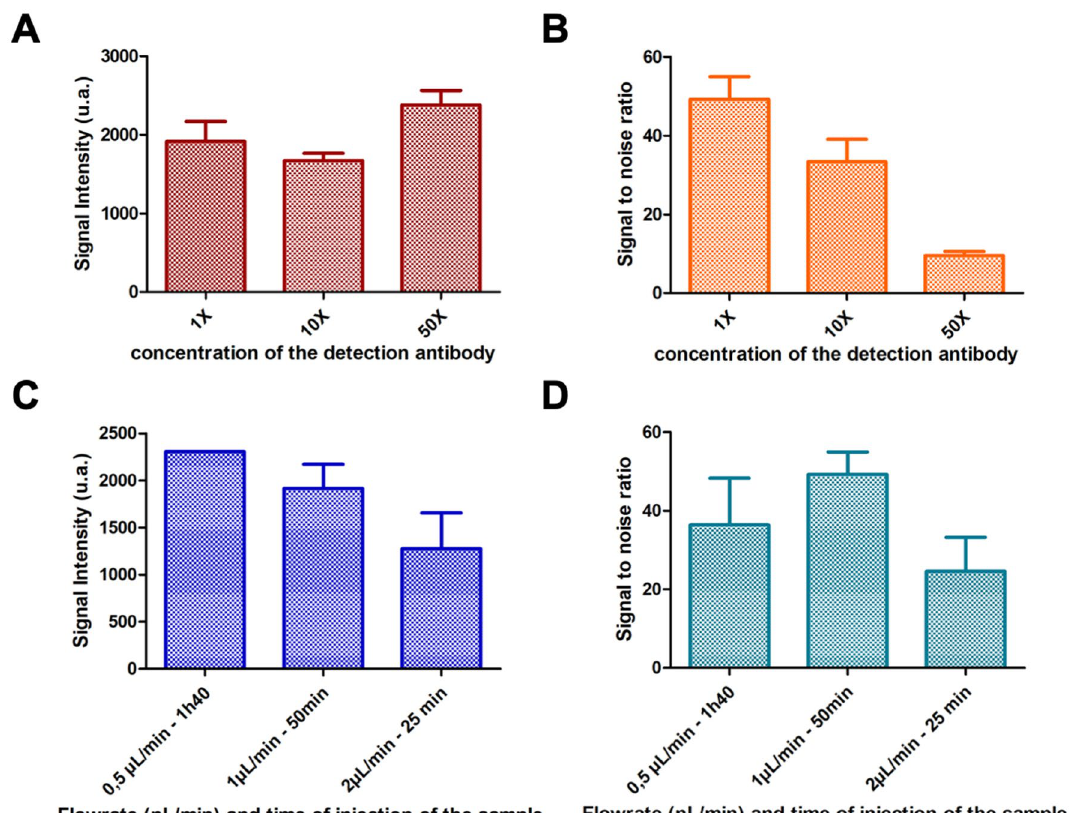
Figure 2. On-chip assay optimization. Signal intensity for a 5 ng/mL sample ( A ) and signal to noise ratio ( B ) of the performed manually in-tube labeling ELISA mode as a function of the concentration of the detection antibody: 0.5 µg/mL, 5 µg/mL and 25 µg/mL. Signal intensity for a 5 ng/mL sample ( C ) and signal to noise ratio ( D ) of the immunoassay as function of the flowrate and the time of injection of the sample for three conditions: 0.5 μL/min, 1 μL/min and 2 μL/min. The analysis was performed as described in the Material and